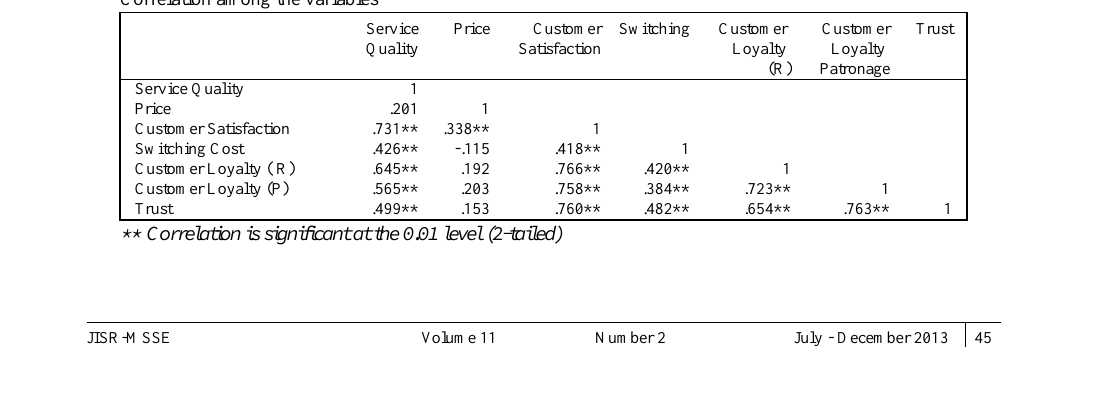
Table 2 Correlation among the variables